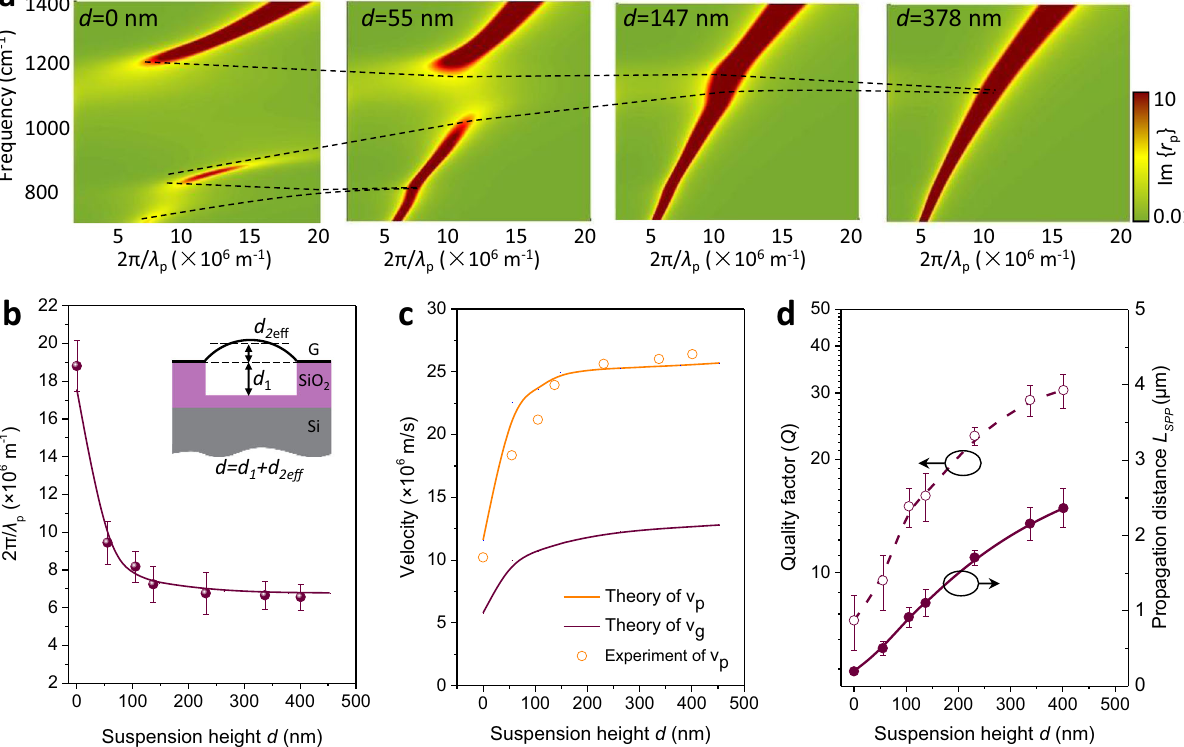
Fig. 3 Active control of suspended graphene plasmons by changing the suspension height. a Calculated imaginary part of the loss function Im{ r p (q, ω )} in the RPA for different suspension heights d , with fi xed E F = 0.65 eV and λ 0 = 10.87 μ m (920 cm − 1 ). The black-dashed curves indicate the evolution of the energy splitting stemming from the coupling between GPs and phonon polaritons in SiO 2 . b Experimentally measured (symbols) and theoretically calculated (solid curve) plasmon wave vector as a function of the suspension height d at λ 0 = 10.87 μ m (920 cm − 1 ). Inset: illustration of a cross-sectional side view of the suspended graphene device. d 1 and d 2eff represent the depth of the dimple and the effective height of the graphene bubble, respectively. The former ( d 1 ) is predetermined by the fabrication process, while d 2eff can be varied in situ by controlling the gas pressure from beneath the substrate fi lm. c Extracted phase (orange curves) and group velocity (maroon curves) as a function of d . Solid curves are theoretical predictions, while symbols are values determined from the experiments. d Quality factor Q (left axis) and intrinsic propagation length L SPP (right axis) of GPs as a function of d . Symbols are obtained from experimental data, while the curves are a guide to the eye. Error bars correspond to different line pro fi les in one scan